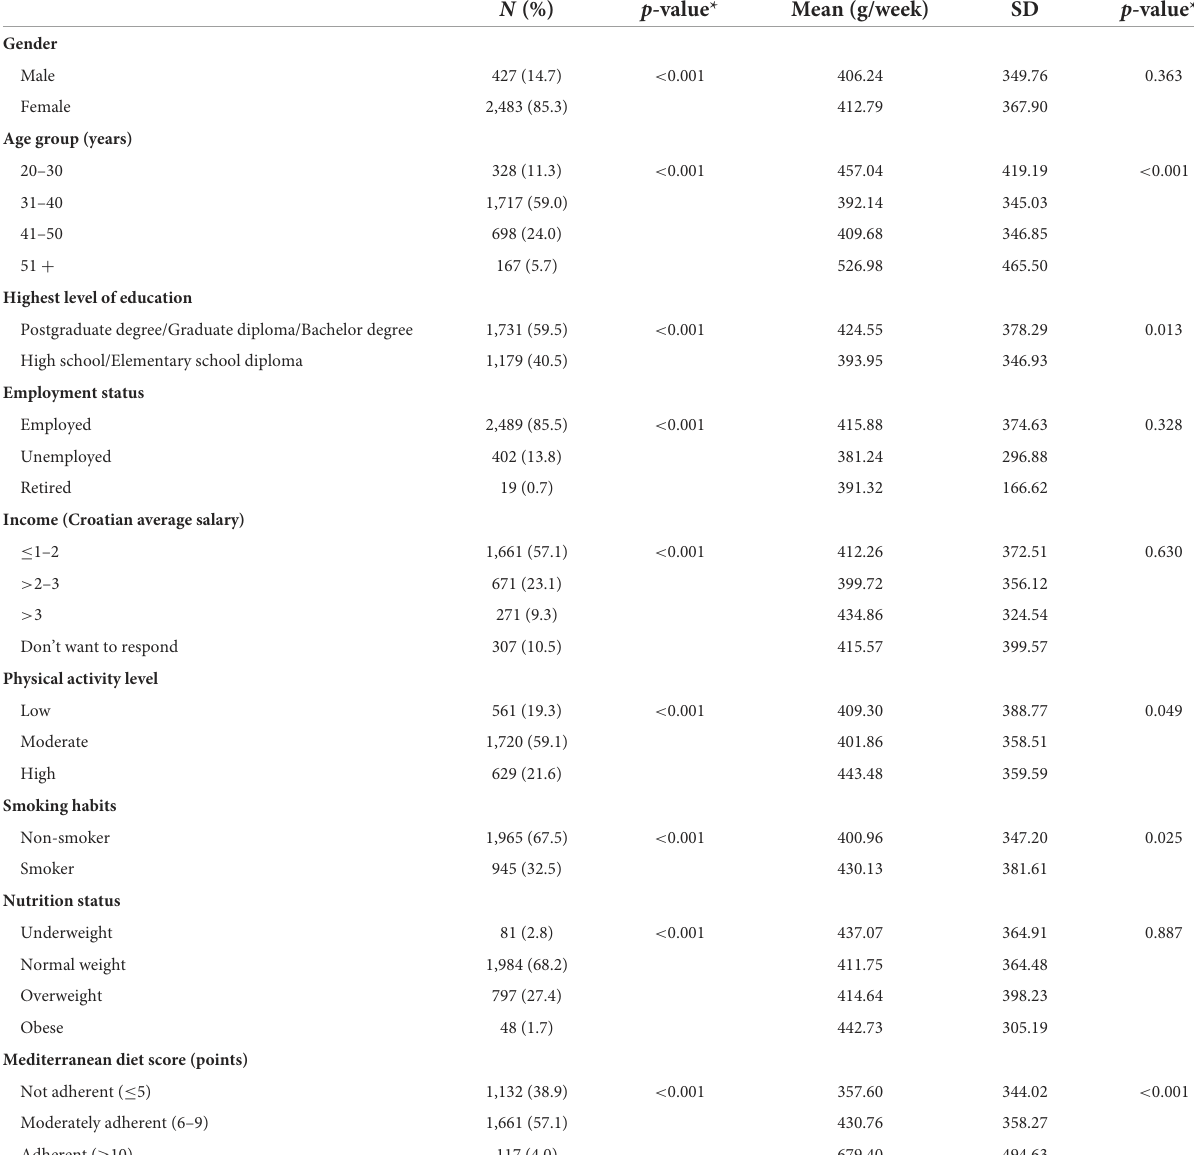
TABLE 1 Socio-demographic characteristics and mean consumption of fish and fishery products among Croatian adults from Primorsko-goranska County ( N = 2,910). N (%) p -value * Mean